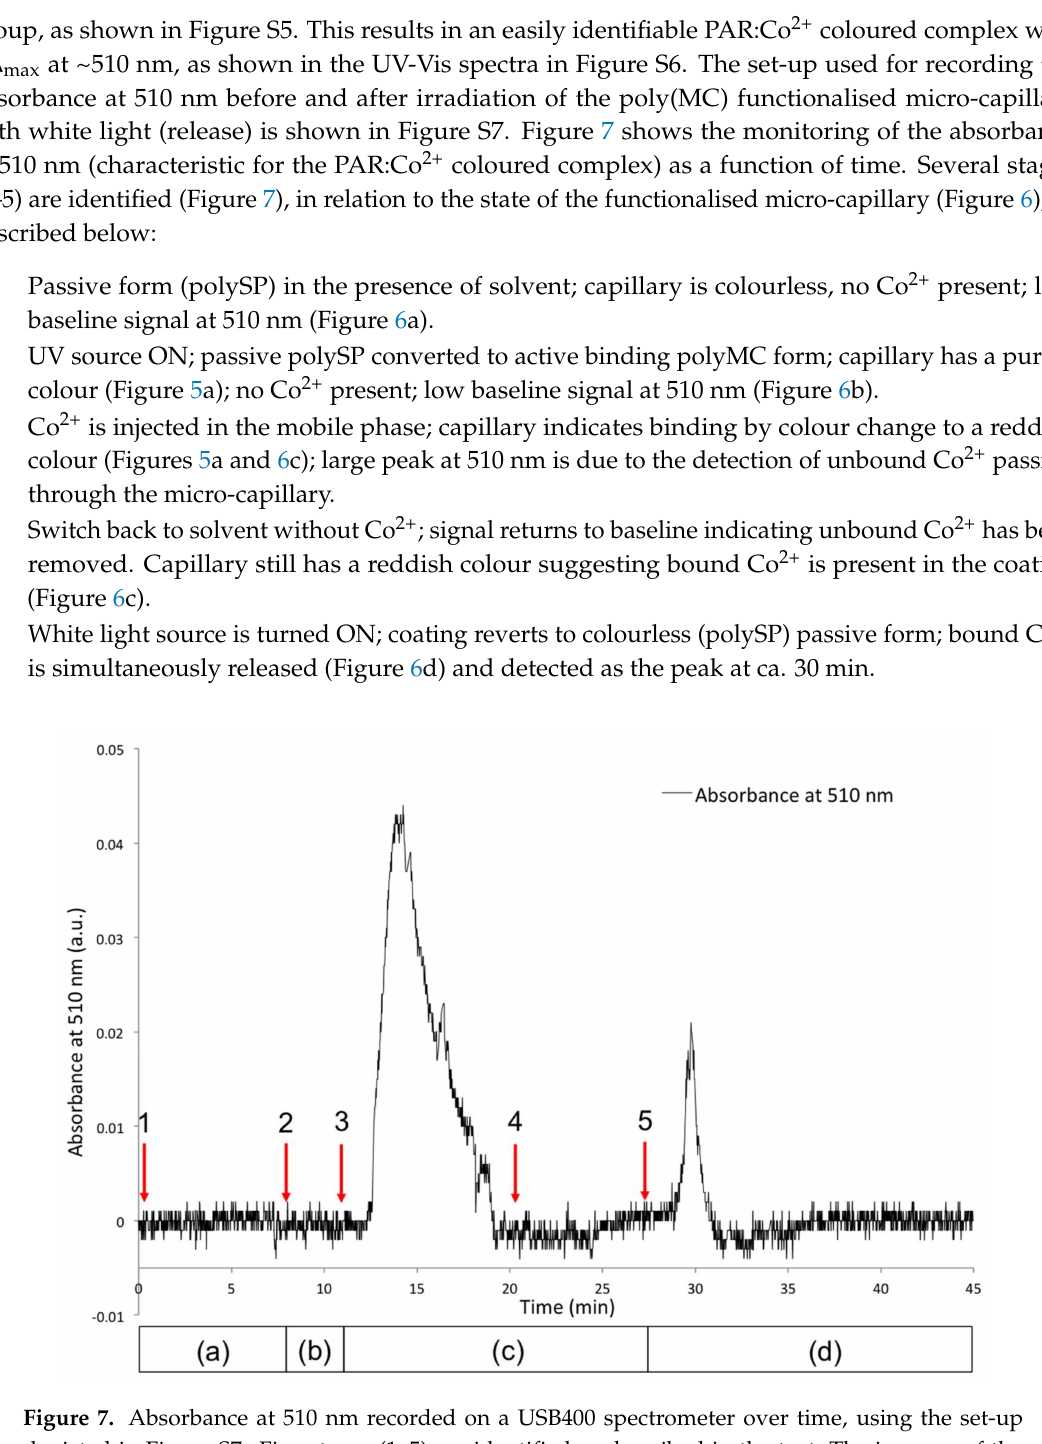
Figure 7. Absorbance at 510 nm recorded on a USB400 spectrometer over time, using the set-up depicted in Figure S7. Five stages (1–5) are identified as described in the text; The increase of the absorbance band centred at 510 nm indicates the presence of PAR-Co 2+ complex; Bottom bar indicates the state of the functionalised micro-capillary as per Figure 6: (a) polySP coated micro-capillary before irradiation; (b) formation of polyMC upon UV irradiation; (c) binding of Co 2+ to polyMC coating; (d) photo-controlled release of Co 2+ upon white light irradiation and regeneration of polySP coating. This experiment confirms the release of Co 2+ from the micro-capillary upon white light irradiation. In the case of Cu 2+ , the micro-capillary maintained its yellow colour after the binding event,